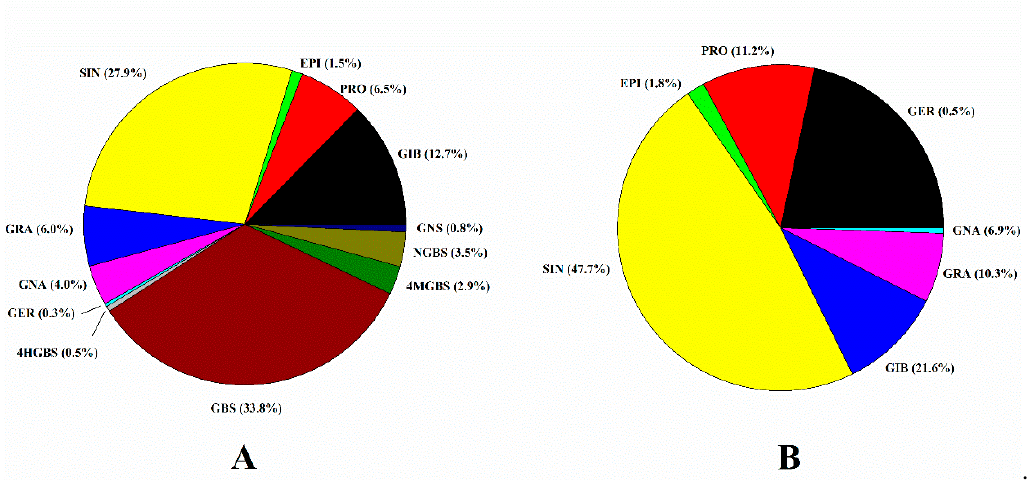
Figure 2. Individual GSL content (%) in total GSLs ( A ) and aliphatic GSLs ( B ) in 146 cabbage